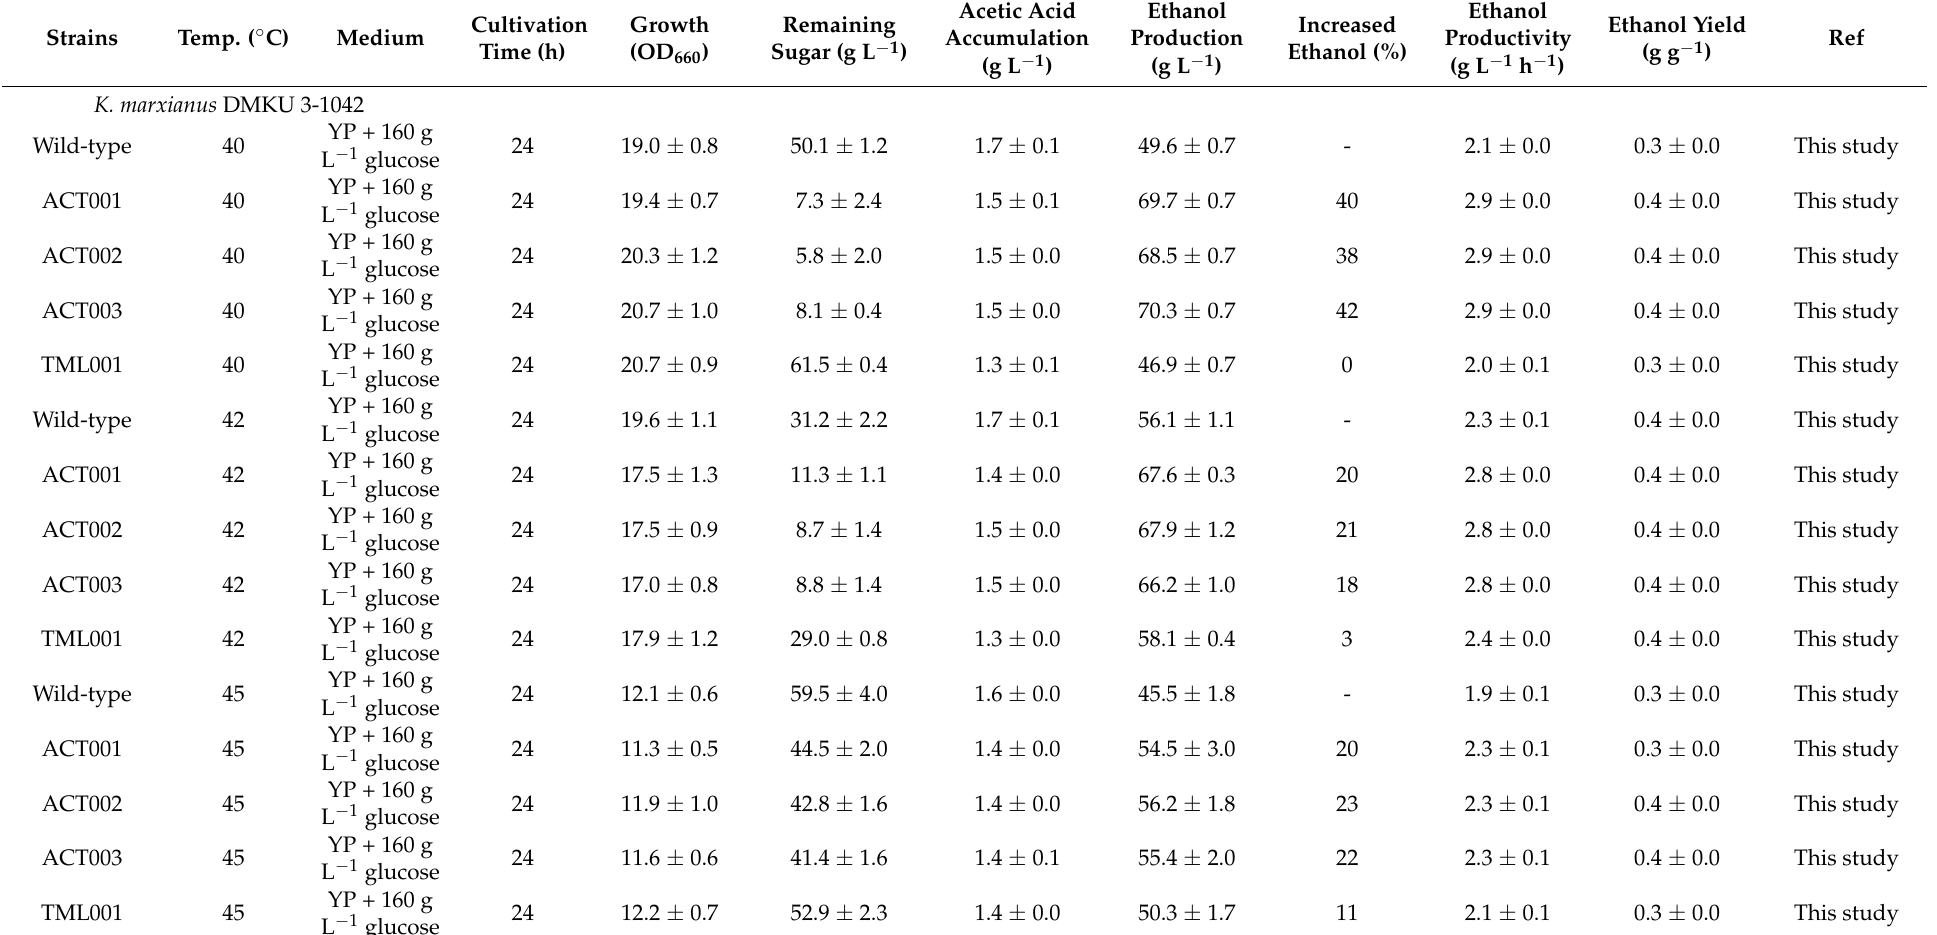
Table 1. Comparison of growth and fermentation parameters among various adapted strains and previously reported